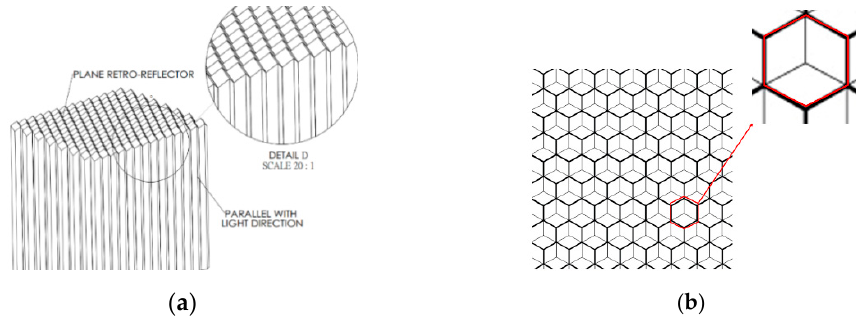
Figure 2. ( a ) A flat corner-cube retro-reflector composed of groups of pins; and ( b ) a group of pins and its reflecting surfaces of the pin groups (red inner region).